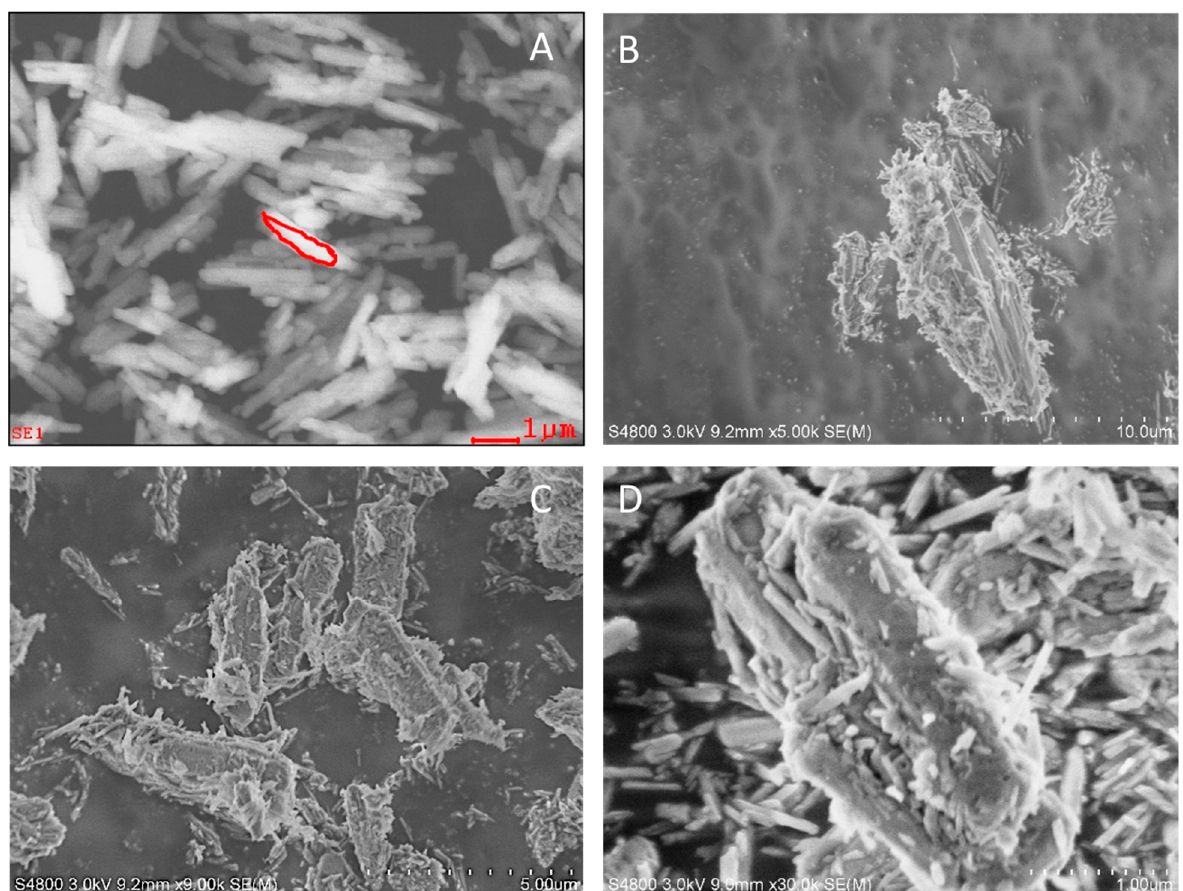
Figure 2. SEM images of HNTs dried under conditions. ( A ) HNT and Sr coated HNTs, ( B ) oven-dried, ( C ) microwaved, ( D ) at room temperature. The red outline is of a single HNT.